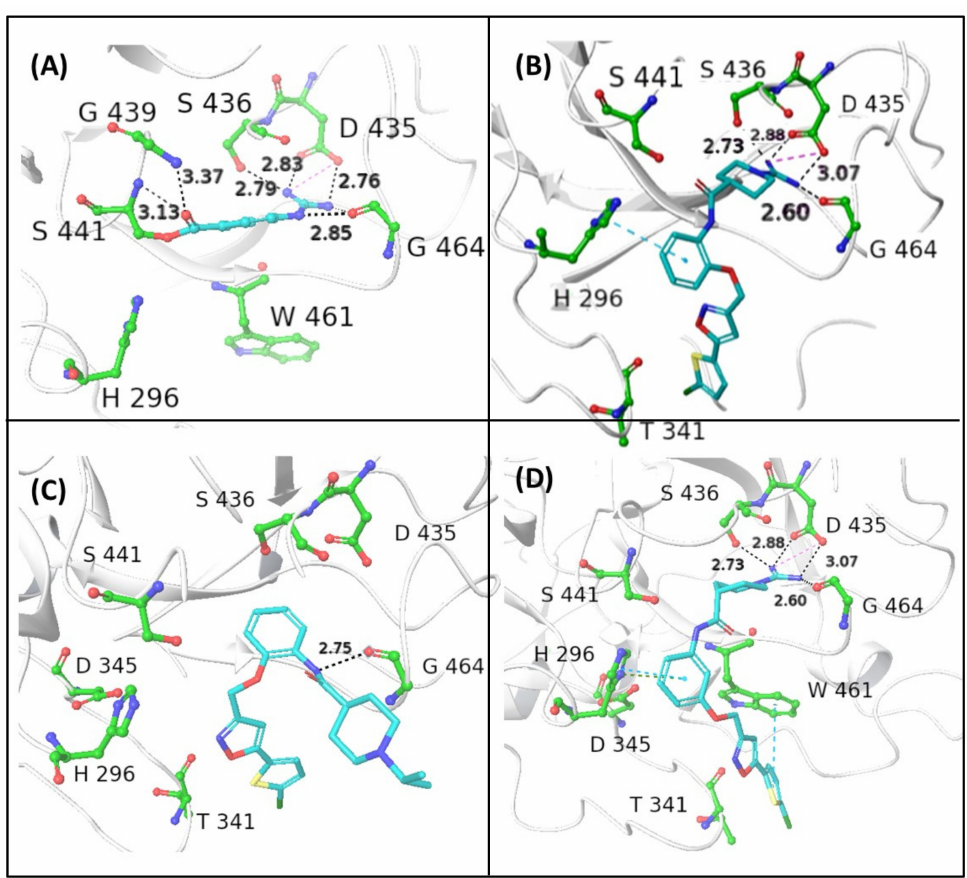
Figure 3. In silico prediction of binding modes of the investigated compounds as ligands of type 2 transmembrane serine protease (TMPRSS2). ( A ) Crystal structure of human TMPRSS2 in complex with the covalent inhibitor nafamostat (pdb code: 7MEQ); the binding interactions with the sur- rounding residues of the catalytic S441 acylated with 4-guanidinobenzoyl moiety are shown. In silico Glide top-scored docking poses of the novel inhibitors 1 ( B ), 2 ( C ), and 3 ( D ) into human TMPRSS2. The inhibitors are represented in sticks, while the amino acid residues are shown in ball-and-sticks. Hydrogen bonds (HBs) and π – π interactions are shown as black and blue dashed lines, respectively (distances in Å); docking scores are expressed in kcal/mol: 1 ( − 7.242), 2 ( − 5.852), and 3 ( −